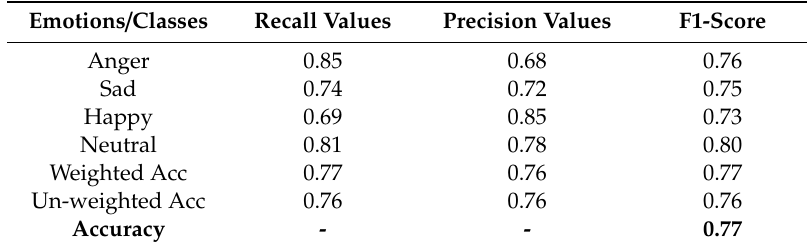
Table 5. Prediction performance of the suggested SER system for the IEMOCAP dataset using speech spectrograms.